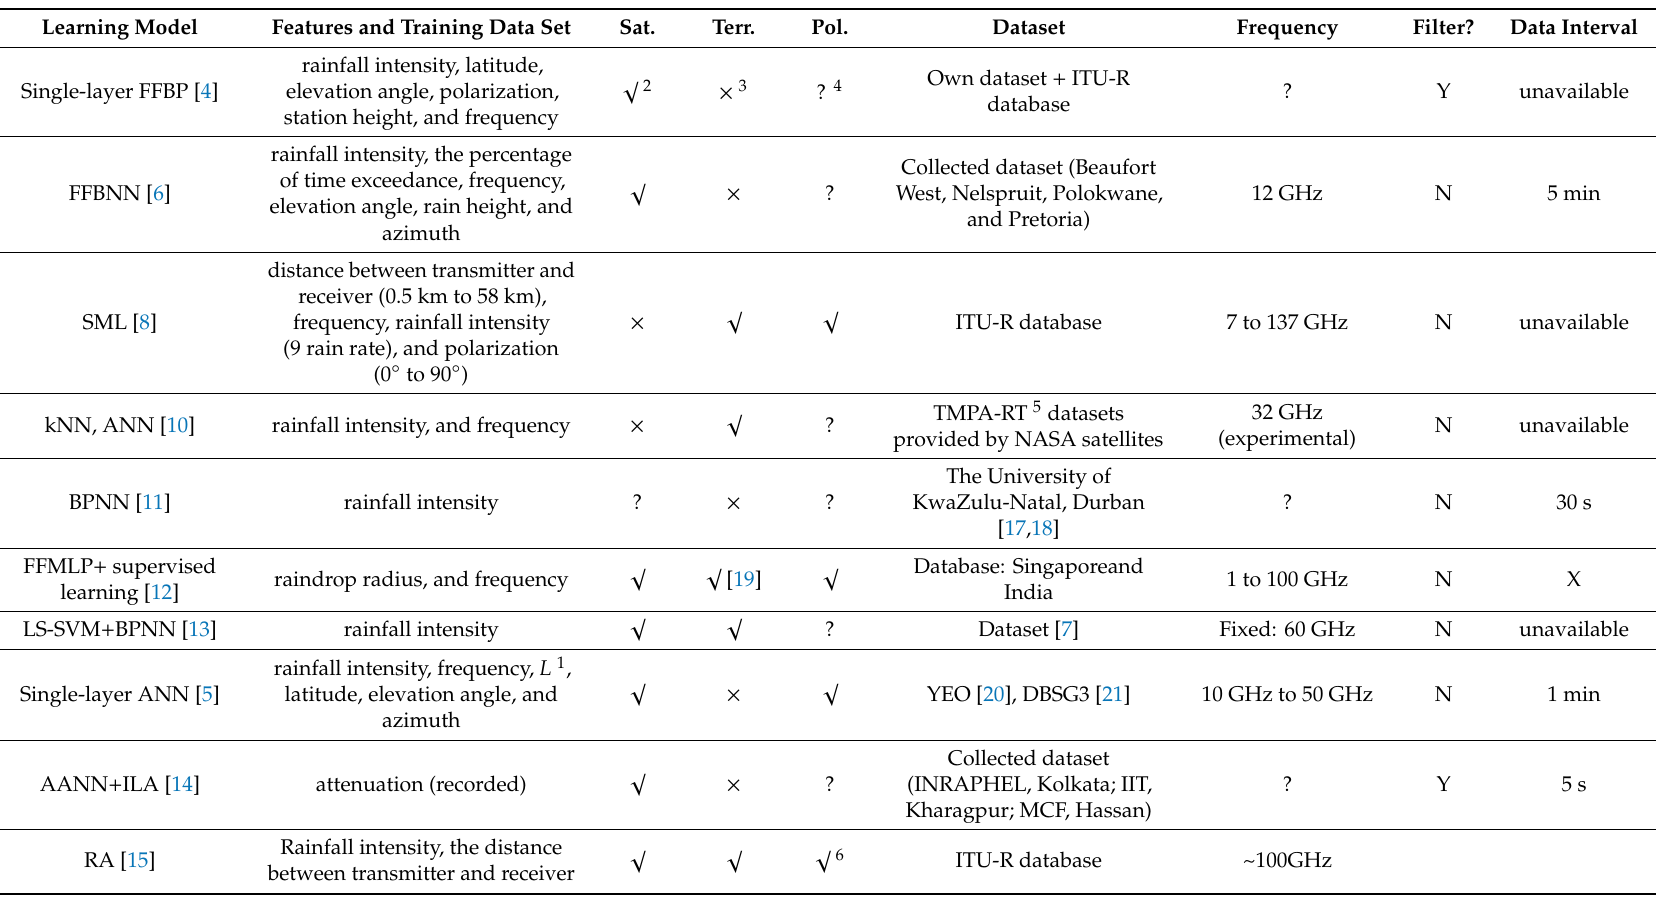
Table 3. Few characteristics of the LARA